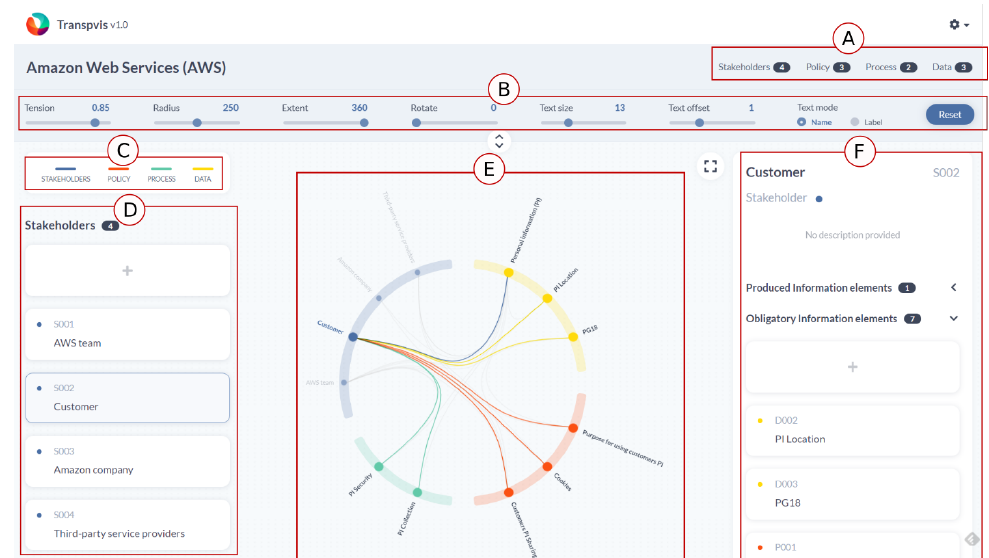
Figure 2. T RANSP V IS : Amazon Web Services (AWS) condition: ( A ) overview information of AWS transparency components, ( B ) control tools, ( C ) color encoding of transparency components, ( D ) de- tailed information in each transparency component, ( E ) circle view of transparency requirements, ( F ) Infolet/SitReq forms.